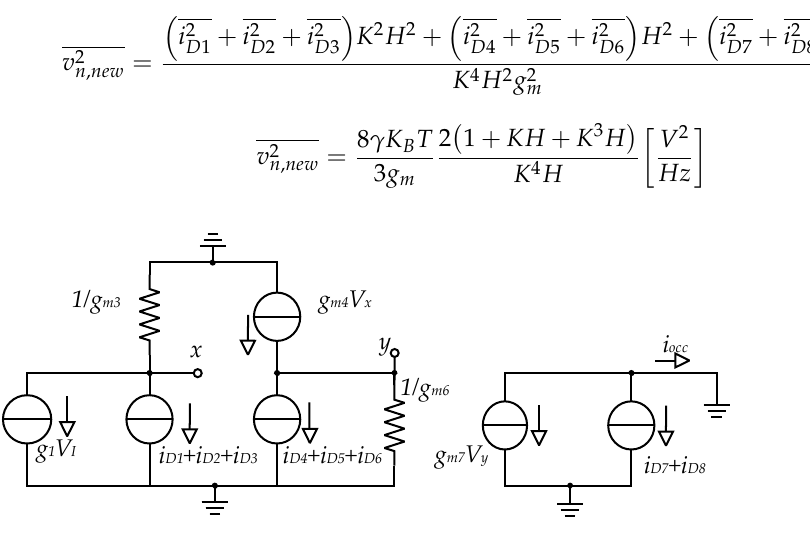
Figure 2. Simplified schematic for noise analysis.